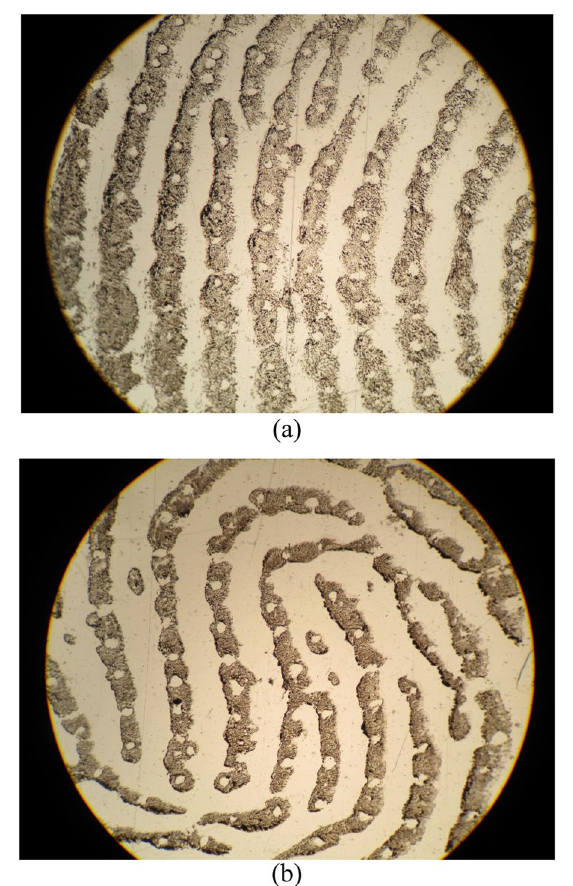
Fig. 2 Photomicrographs of fingerprint recorded on the sticky side of adhesive tape a using method (ii) and b using method (iii), captured at 40 magnification using Zeiss Primo Star microscope attached Fig. 1 Photomicrographs of fingerprint recorded on a glass and b × with Canon PowerShot G10 camera (Automode) using a sticky side of adhesive tape, captured at 40 magnification using × Zeiss Primo Star microscope attached with Canon PowerShot G10 camera (Automode) using a SOLIGOR Adaptor tube for Canon 10 (52 mm wide)